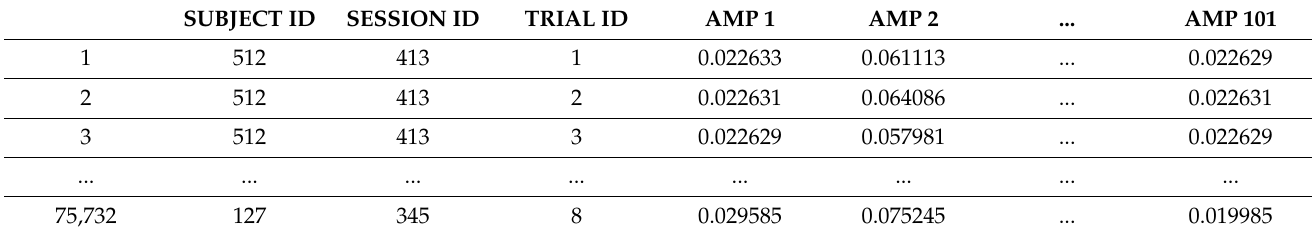
Table 2. Example of a GRF Amplitude CSV file.